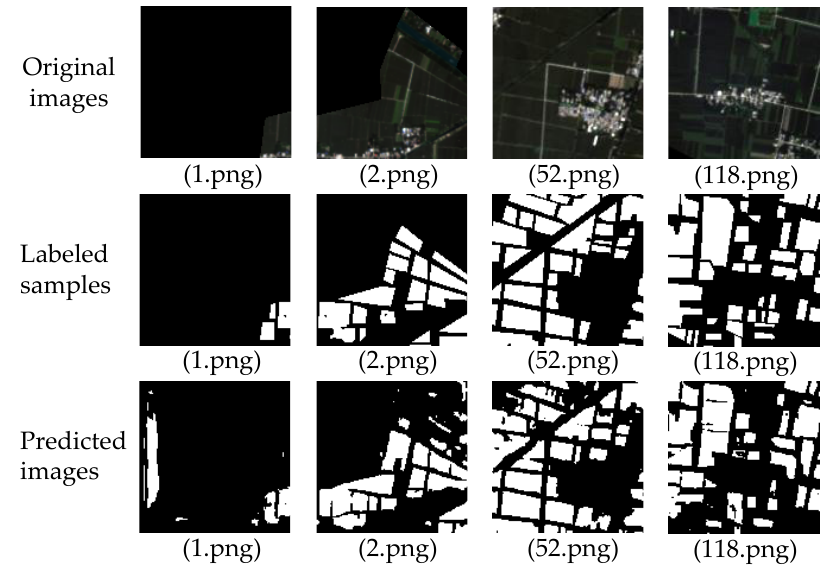
Figure 6. The test results under the 128 × 128 px cropping size.